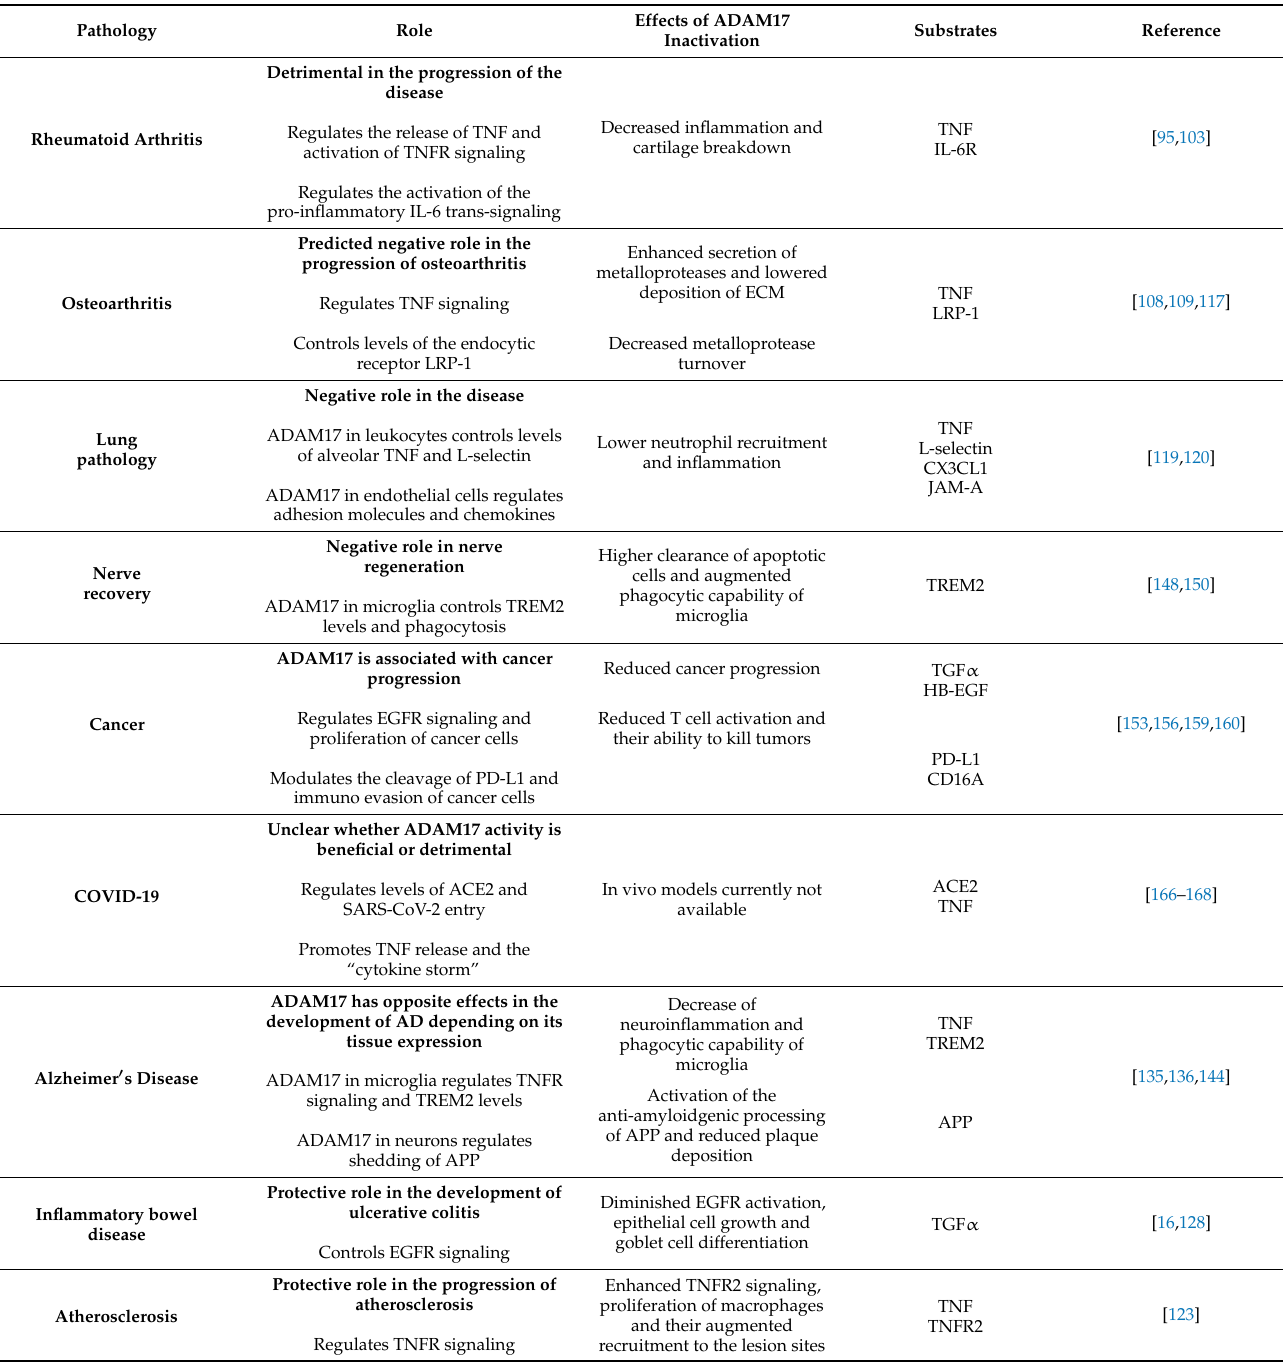
Table 2. Diseases in which ADAM17 has been